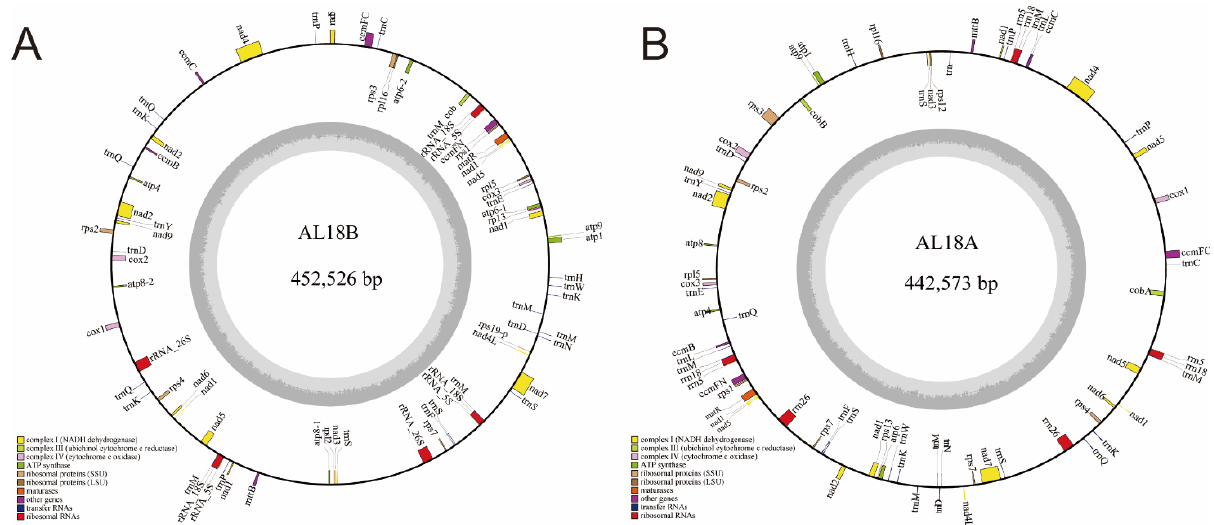
Figure 3. Circle map of AL18B ( A ) and AL18A ( B ) mitochondrial genome. Genes on the forward and reverse strands are presented on the outside and inside of the circle, respectively. The two gray layers represent the GC content in the mitochondrial genome. Table 3. Comparison of coding genes in different mitochondrial genomes.